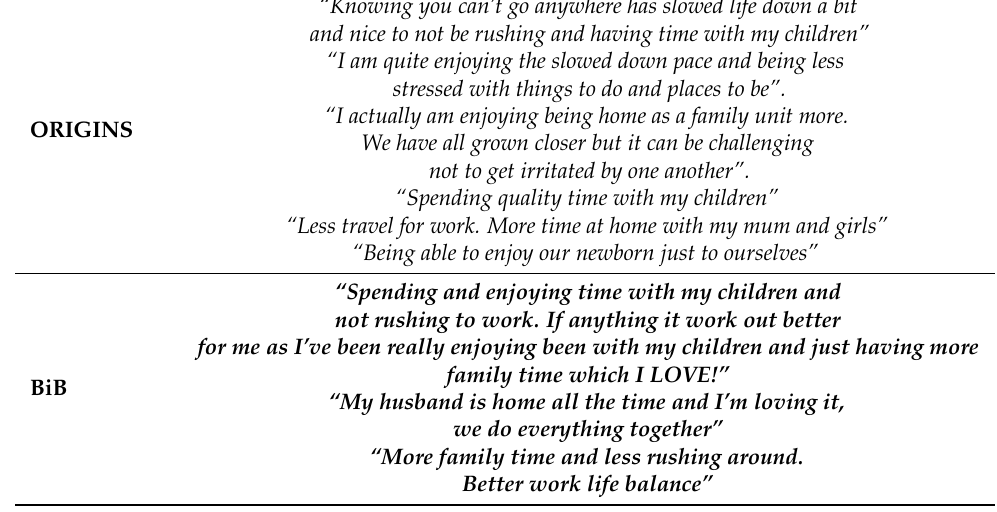
Table 7. Enjoyable aspects: Sample responses.